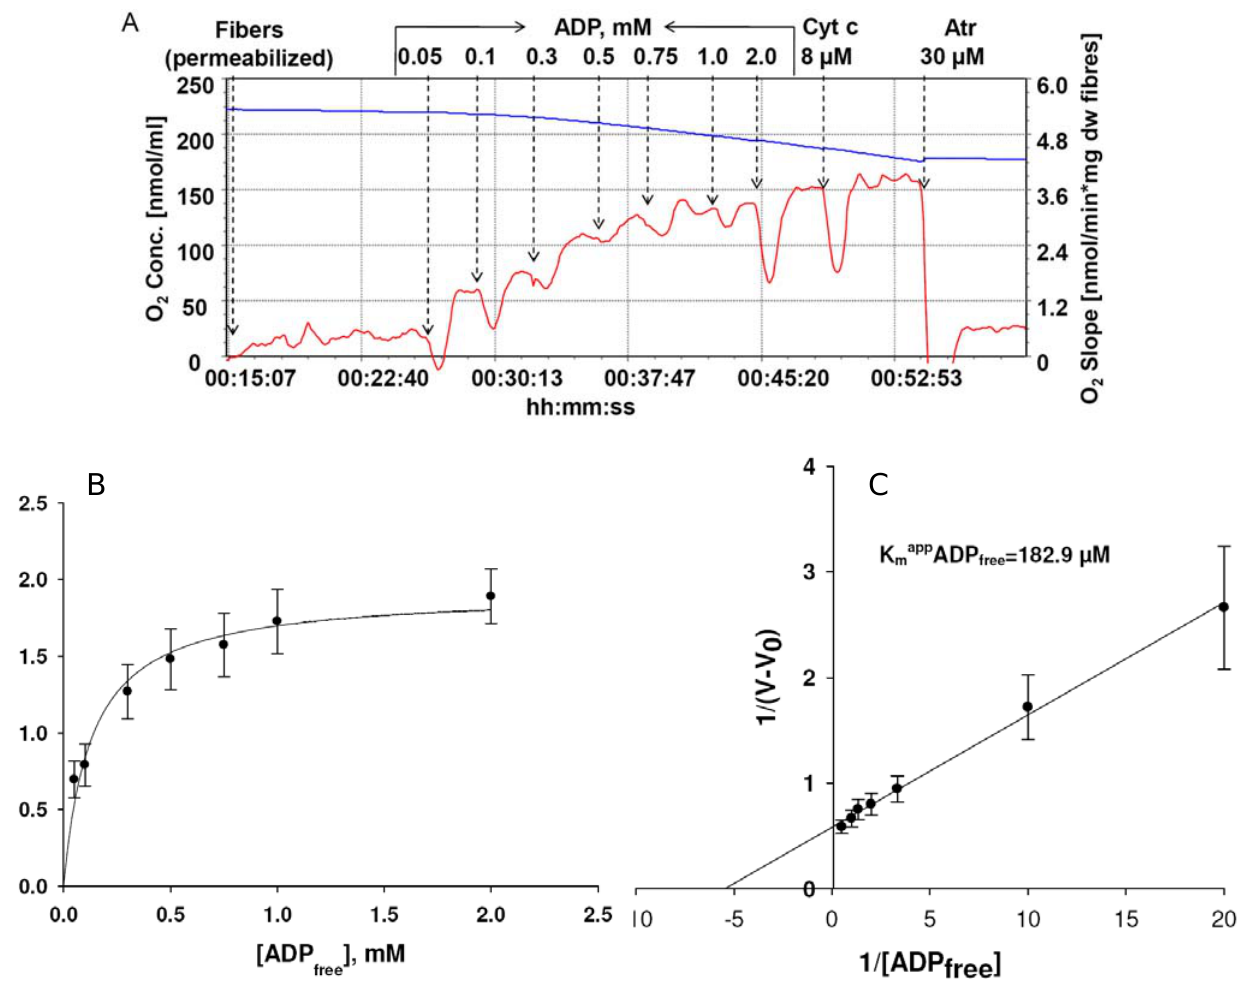
Figure 1. Kinetic analysis of respiration regulation by ADP in permeabilized fibres from human vastus lateralis muscle. Biopsy samples were taken from healthy volunteers and permeabilized fibers prepared as described by Kuznetsov et al . [88]. (A) Oxygraph recording of respiration rates during stepwise stimulation by increasing amounts of ADP in the presence of 5 mM glutamate and 2 mM malate. Cytochrome c and atractyloside are used to test the integrity of mitochondria outer and inner membranes. (B) Henri-Michelis- Menten type hyperbolic function of dependence of oxygen consumption rate on ADP concentrations. (C) Linearization of data from Figure 1B in double reciprocal plot gives the value of apparent Km for free ADP equal to 182.9 µM (n = 10). This value corresponds to mixed fibre muscle content (for comparison: in glycolytic gastrocnemius rats’ muscle the Kmapp for free ADP is about 20 µM and for highly oxidative cardiac muscle is about 300–400 µM). Reproduced from [92] with